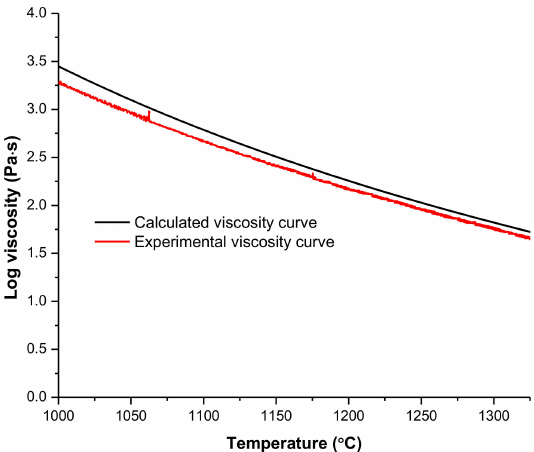
Figure 1. Calculated and experimental viscosity curves for a borosilicate glass